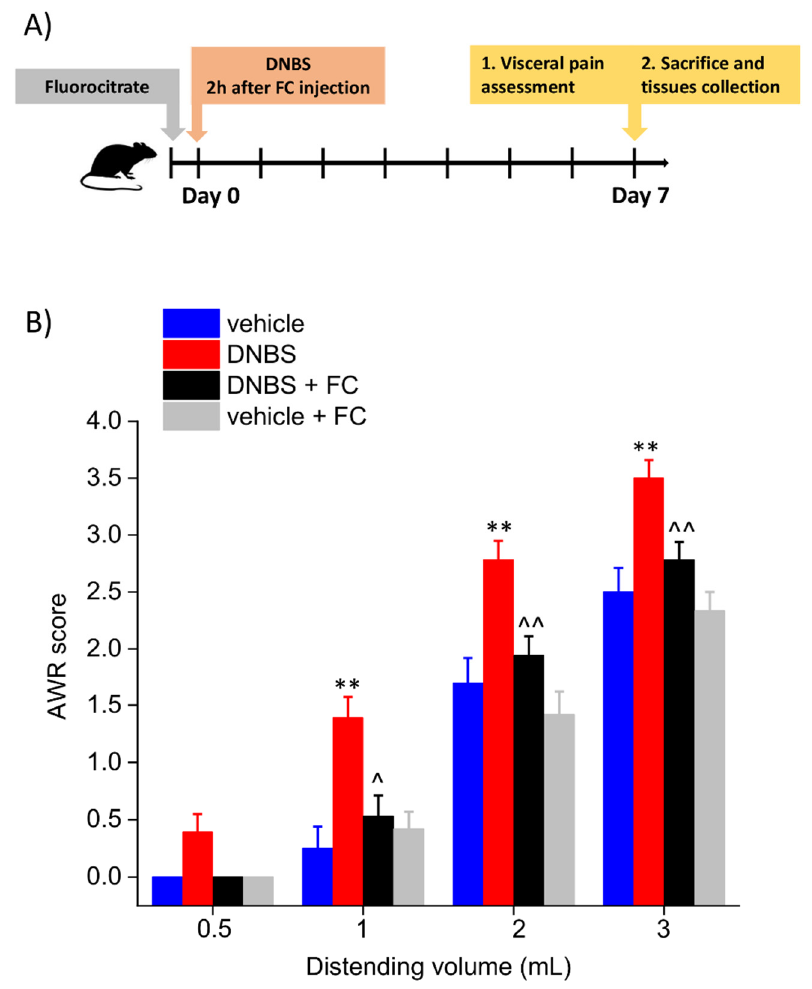
Figure 1. Effect of systemic fluorocitrate administration on the development of visceral pain after DNBS injection. Experimental scheme ( A ); Abdominal withdrawal reflex (AWR) in response to colorectal distension ( B ). Each value represents the mean ± SEM of 8 animals per group. ** p < 0.01 vs. vehicle. ^ p < 0.05 and ^^ p < 0.01 vs. DNBS.